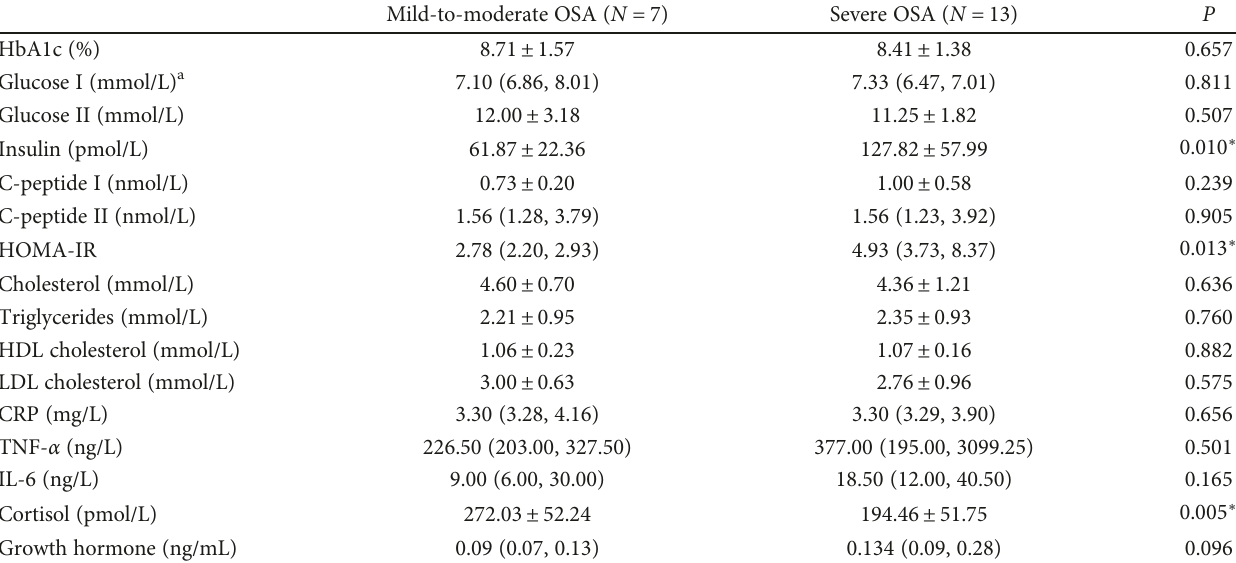
Table 5: Biochemical parameters of OSA with T2DM patients.